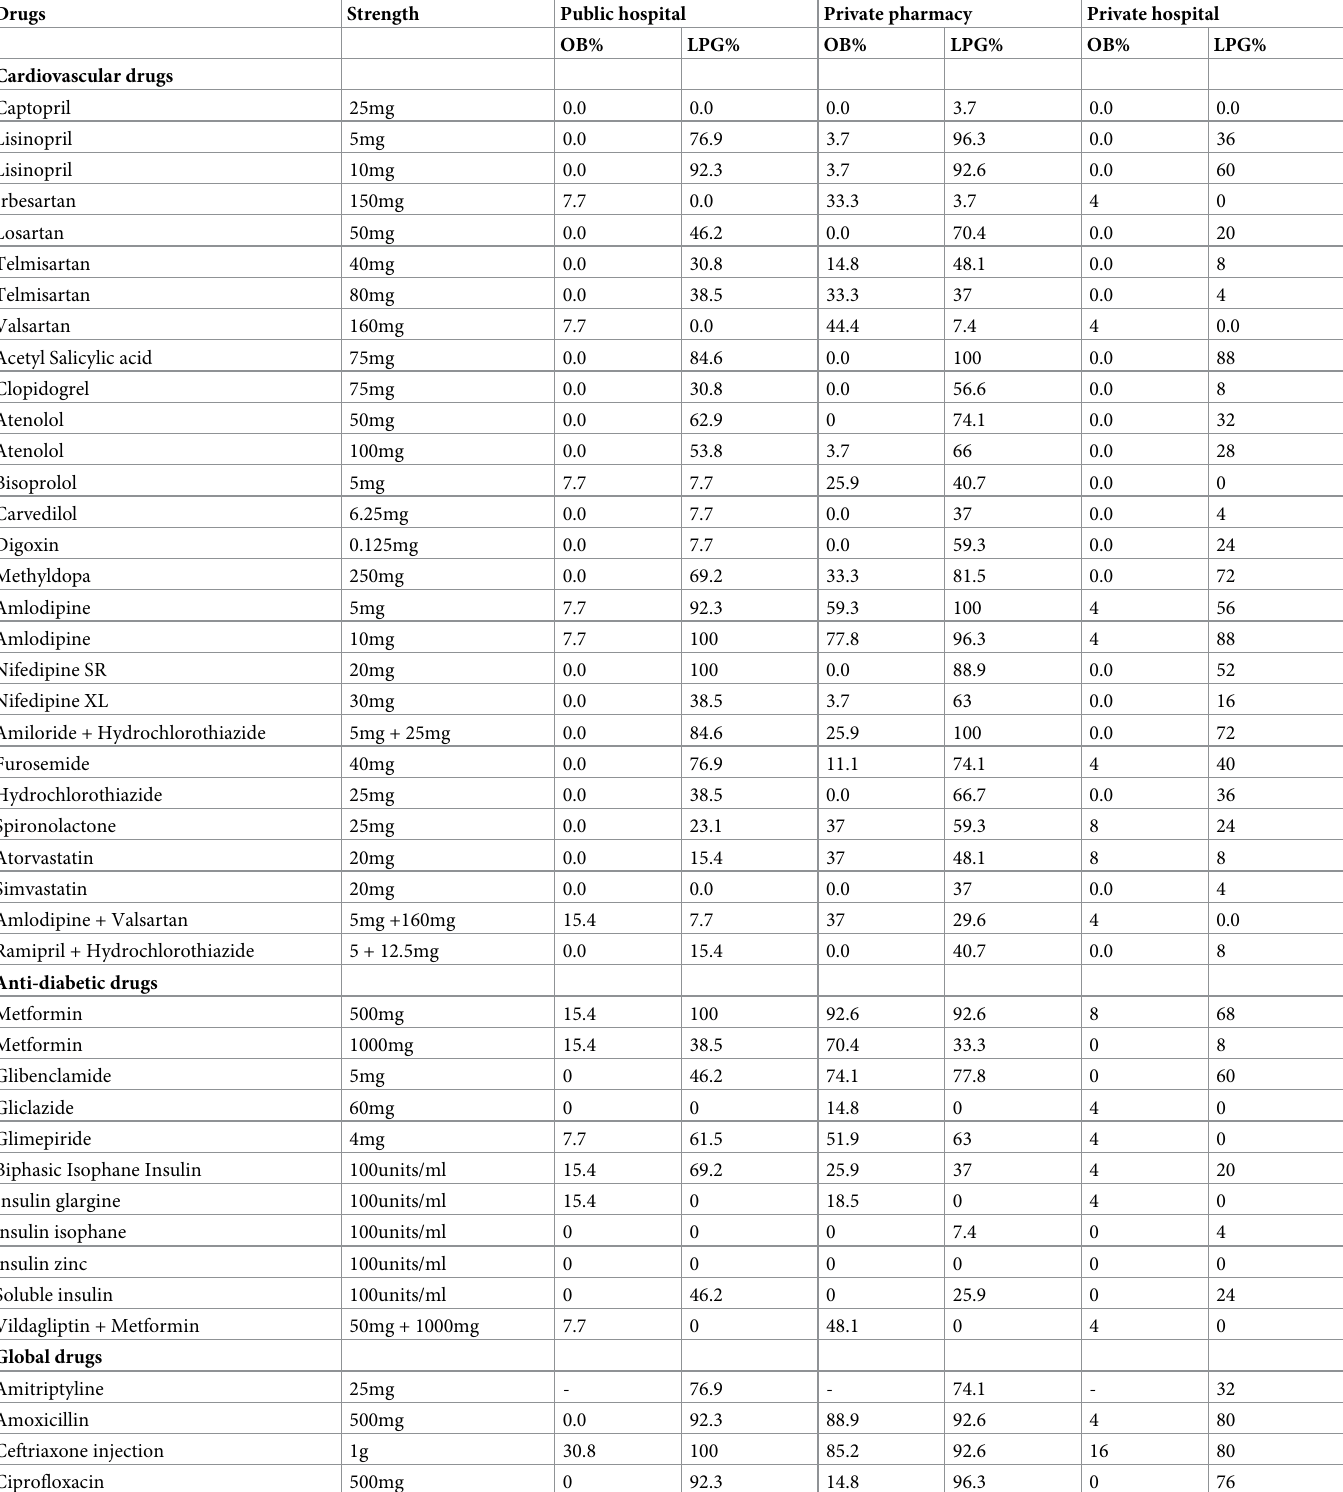
Table 1. Availability of cardiovascular, anti-diabetic, and global drugs by pharmacies.